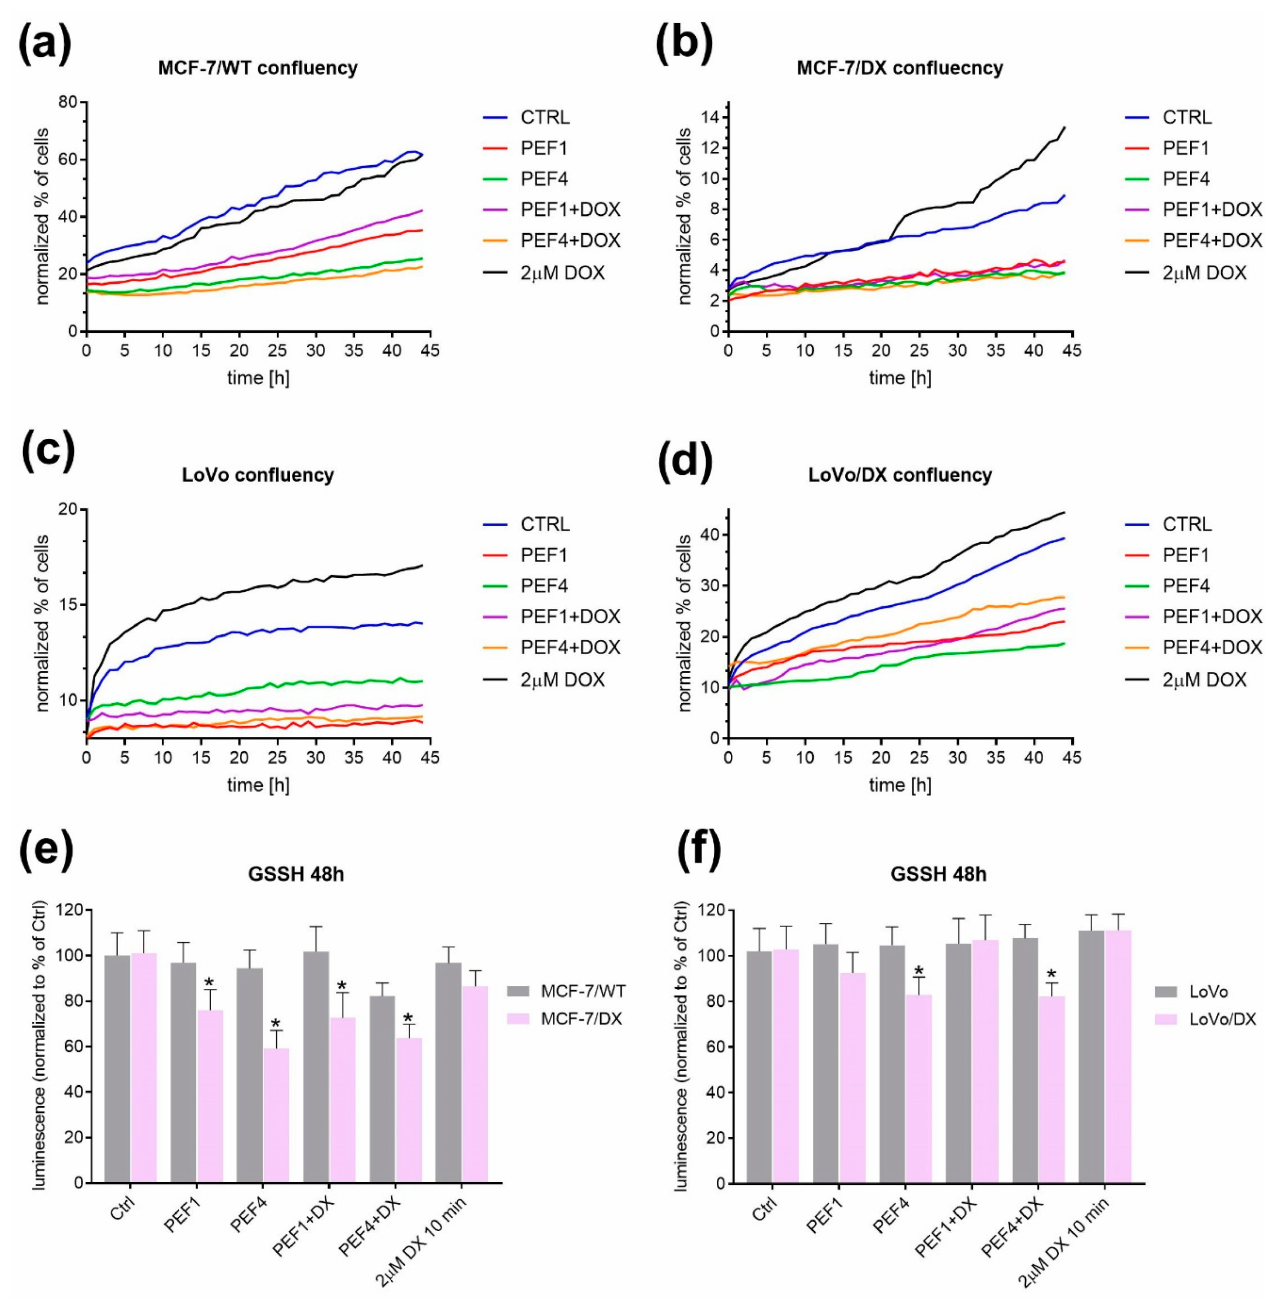
Figure 7. The analysis of the effects after exposure to electrical pulses without and with doxorubicin (DOX, C DOX = 2 µ M) on cells’ confluency analyzed during 44 h for breast cancer MCF-7/WT ( a ) and MCF-7/DX ( b ) cells, and colon cancer LoVo ( c ) and LoVoDX ( d ) cells; the evaluation of reduced glutathione (GSSH) in breast cancer ( e ) and colon cancer ( f ) cells. The following treatment protocols were used: PEF1 —10 kV/cm × 300 ns × 200; PEF4—1.2 kV/cm × 100 µ s × 8 (ESOPE). All the data are normalized to untreated control. Asterisk (*) corresponds to statistically significant ( p < 0.05)